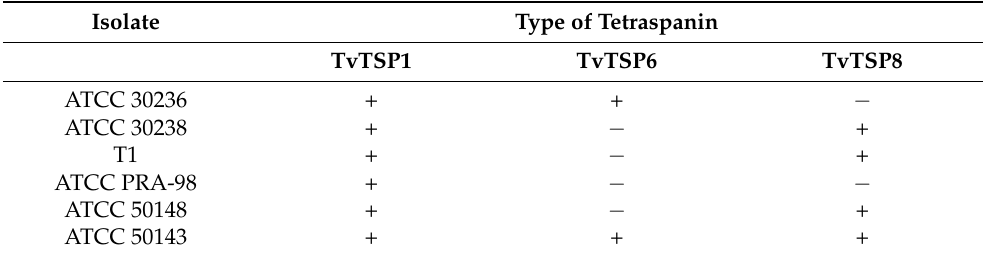
Table 2. Type of tetraspanin proteins present in each proteome of sEVs by LC-MS/MS.